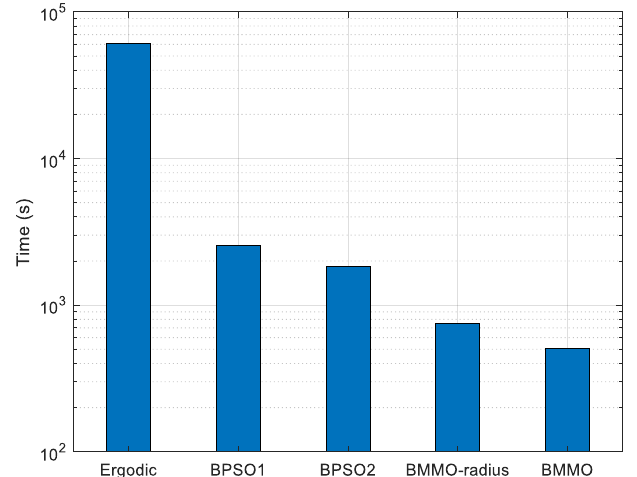
Figure 9. Computational costs of different methods tested on the computer with the configuration;